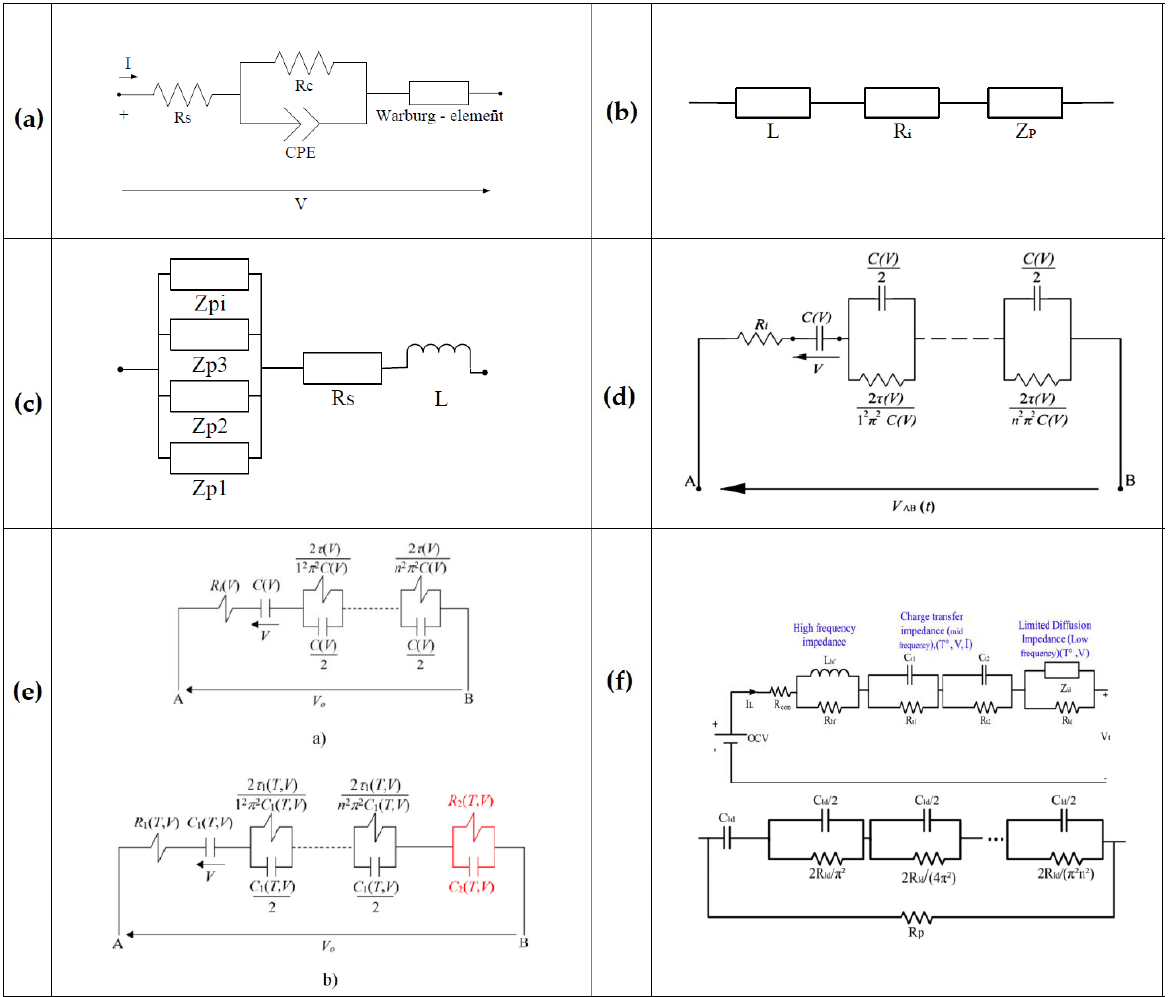
Figure 9. The developed fractional-order models [26]. ( a ) a basic FOM, ( b ) ECM with three compo- nents in series, ( c ) the same ECM with four parallel impedance branches, ( d ) developed FOM, in which the impedance is modeled by considering the ambient temperature at various currents ( e ) an enhanced FOM regarding the influence of the cell’s temperature, ( f ) an advanced FOM that models impedance behavior in the frequency domain.